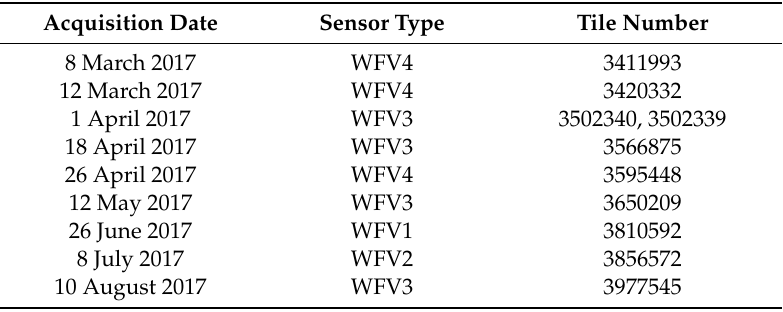
Table 2. Information of the GF-1 WFV data used in this